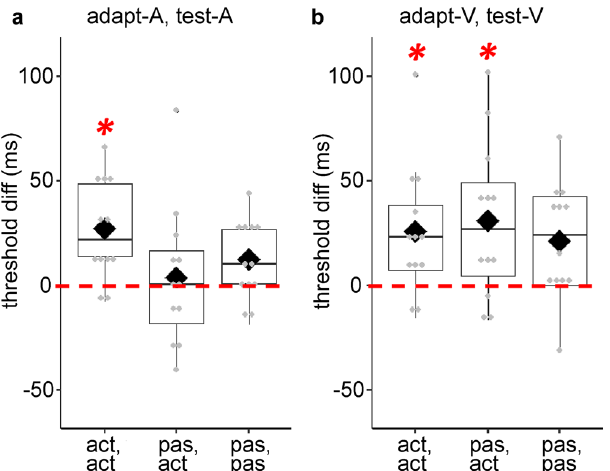
Figure 3. Boxplots with individual data points showing significant effect of adaptation delay (threshold differences between 150 and 0 ms delay conditions) as a function of adaptation, test mode in ( a ) the adapt-A, test-A condition, and ( b ) the adapt-V, test-V condition. The dashed line depicts 0 difference. Diamonds and solid lines show the mean and the median values of the data, respectively. Asterisks show significant